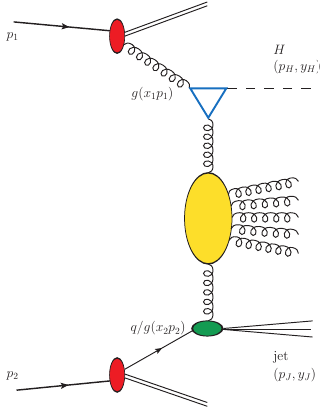
Figure 1: Higgs-jet hadroproduction process